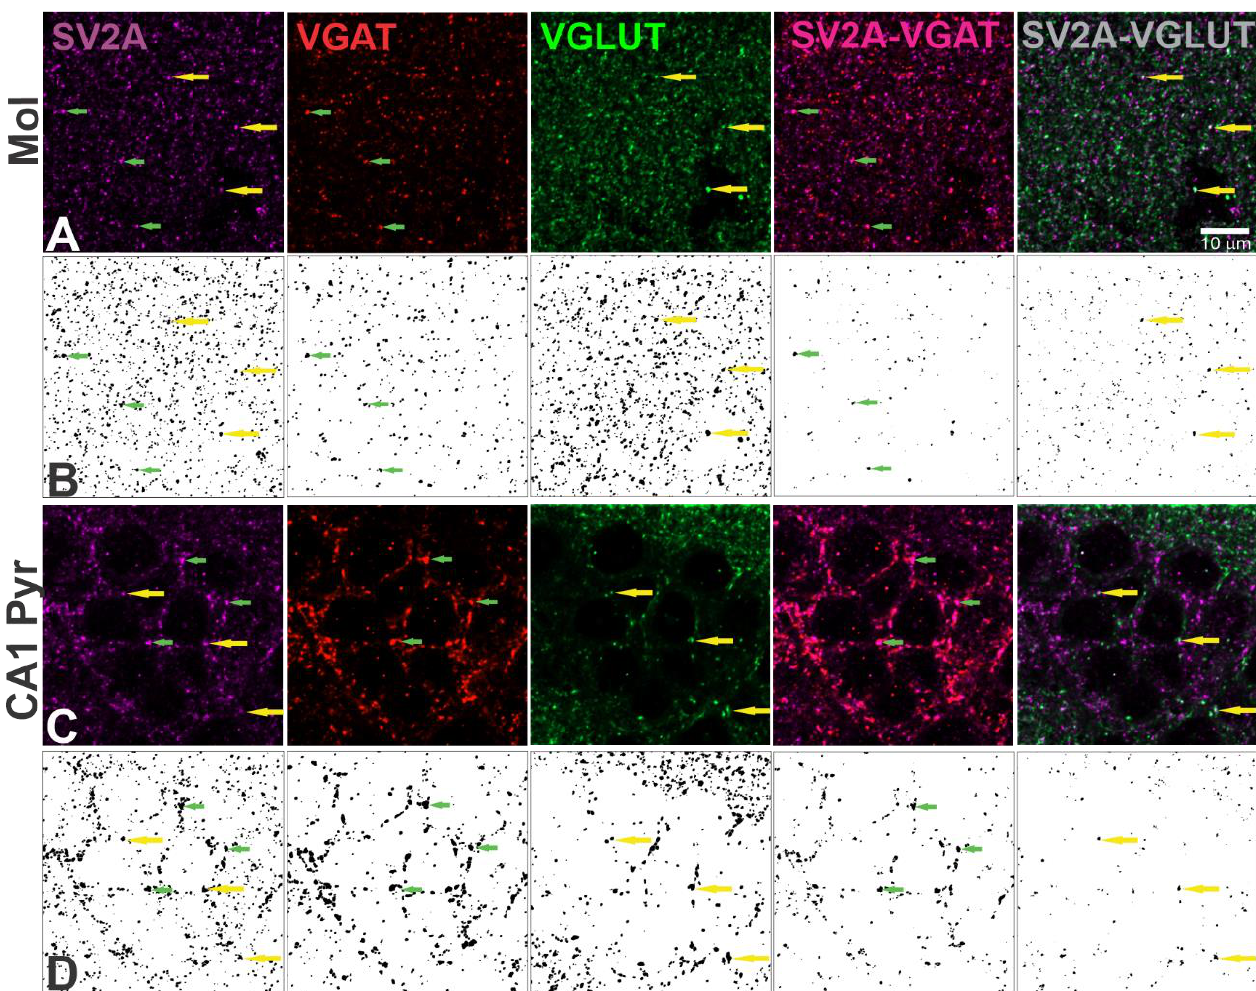
Figure 2. Example of immunofluorescent quantified puncta, using the Fiji plugin Synapse Counter, in high magnification images. ( A , C ) Confocal images of the molecular (Mol) and CA1 pyramidal (CA1 Pyr) layers with SV2A (purple), VGAT (red) or VGLUT (green) puncta, as well as SV2A-VGAT (magenta) or SV2A-VGLUT (gray) co-localized puncta. ( B , D ). Black and white images of puncta detected with Synapse Counter; each point corresponds to an immunofluorescent punctum. In each image, green arrows show SV2A-VGAT co-localized puncta, yellow arrows show SV2A-VGLUT co-localized puncta (scale bar = 10 µm).